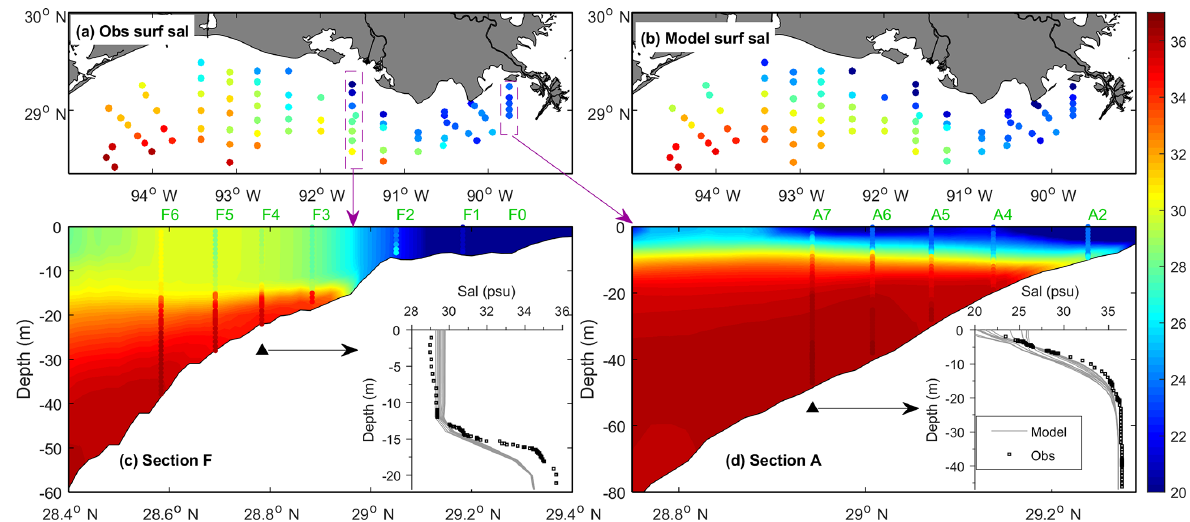
Figure 5. Salinity distribution at the Texas–Louisiana shelf from the shelf-wide survey on 22–27 July 2018: comparison of (a) observed and (b) modeled surface salinity and of the vertical profiles at two cross-shelf sections, (c) F and (d) A. In (c) and (d) , the colored dots indicate observed salinity, while the filled colors indicate modeled salinity, and the insets compare the vertical profiles of salinity at the selected stations of F4 and A7, respectively. The grey lines in the insets show the 12 modeled profiles over 1d (observation time ± 0 . 5d).